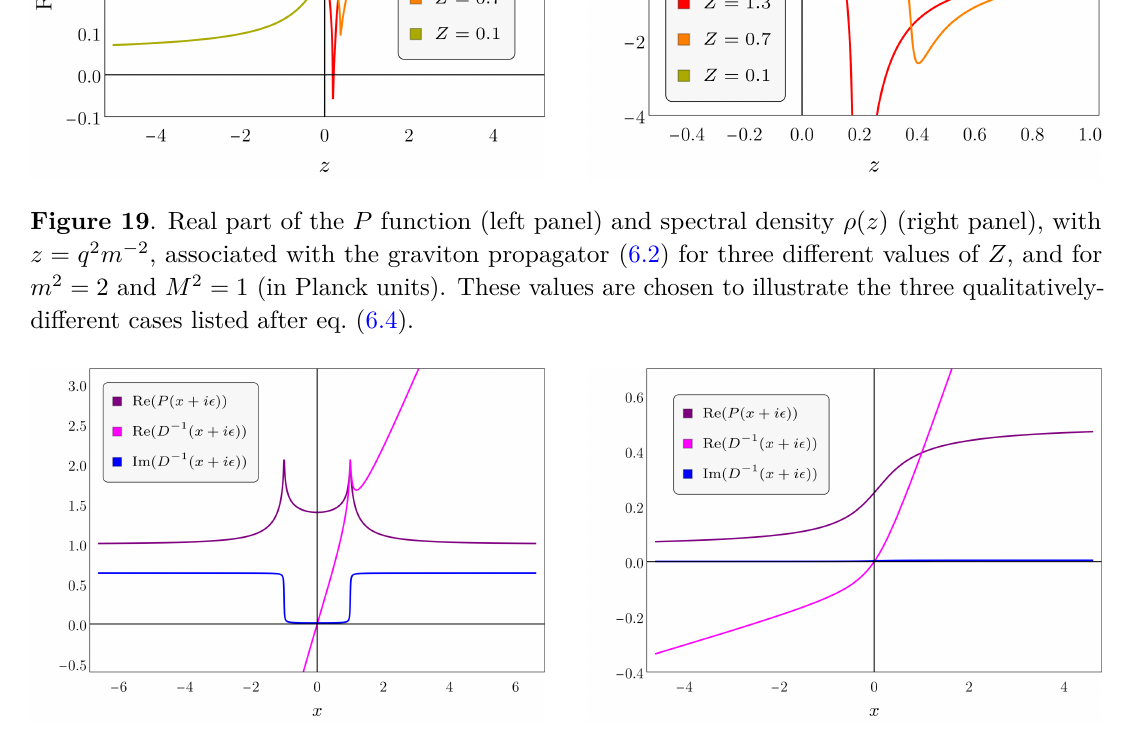
Figure 20 . Comparison of the real and imaginary parts of the propagators in eq. (6.1) (case α < 0 , with α = − 0 . 2 to produce the plot in [131], here in the left panel) and (6.2) (case Z < M 2 /m 2 , with Z = 0 . 1 to produce the plot in the right panel). In both cases, the real part of P ( x ) = x − 2 D − 1 ( x ) (purple line) is positive, while the imaginary part of D − 1 ( x ) (blue line) is non-zero only along the branch cuts. Since for the case Z < M 2 /m 2 the branch cuts are not along the real q 2 -axis, the imaginary part of D − 1 ( z ) is zero for z ≡ x = Re z . The real part of the inverse propagator D − 1 ( z ) (magenta line) has thereby one single massless